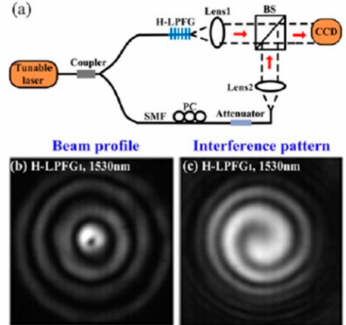
Figure 30. ( a ) Schematic diagram of experimental setup for detecting the generated OAM modes; ( b , c ) beam profile and interference pattern of the generated OAM + 1 mode by the HLPFG in SMF at the resonant wavelength [13].